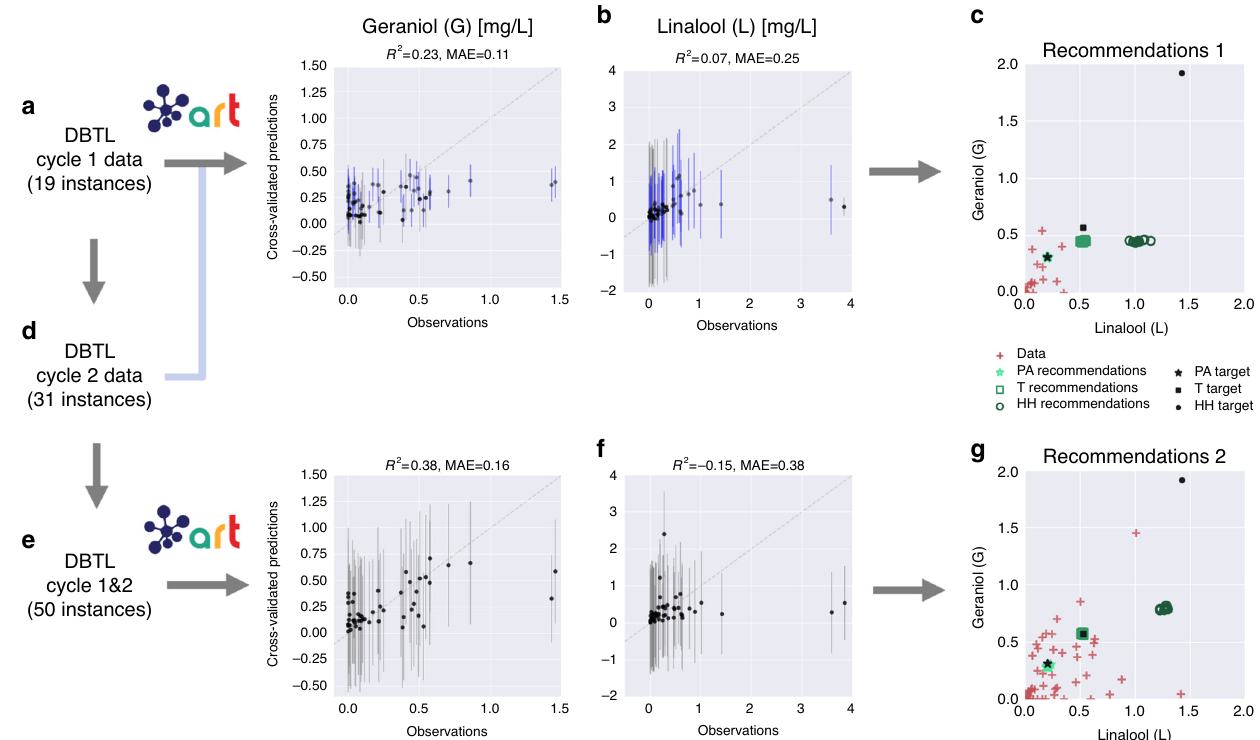
Fig. 8 ART produces effective recommendations to bioengineer yeast to produce hoppy beer. The 19 instances in the fi rst DBTL cycle ( a ) were used to train ART, but it did not show an impressive predictive power (particularly for L ( b )). In spite of it, ART is still able to recommend protein pro fi les predicted to reach the Pale Ale (PA) target fl avor pro fi le, and others that were close to the Torpedo (T) metabolite pro fi le ( c green points showing mean predictions). Adding the 31 strains for the second DBTL cycle ( d , e ) improves predictions for G but not for L ( f ). The expanded range of values for G & L provided by cycle 2 allows ART to recommend pro fi les which are predicted to reach targets for both beers ( g ), but not Hop Hunter (HH). Hop Hunter displays a very different metabolite pro fi le from the other beers, well beyond the range of experimentally explored values of G and L, making it impossible for ART to extrapolate that far. Notice that none of the experimental data (red crosses) matched exactly the desired targets (black symbols), but the closest ones were considered acceptable. R 2 and mean absolute error (MAE) values are for cross-validated mean predictions (black data points) only. Bars indicate 95% credible interval of the predictive posterior